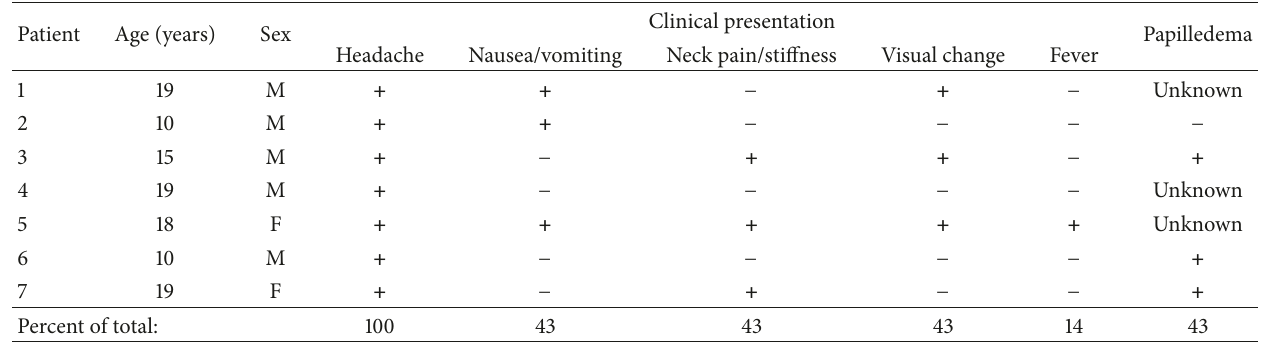
Table 1: Patient demographics and presenting symptoms.